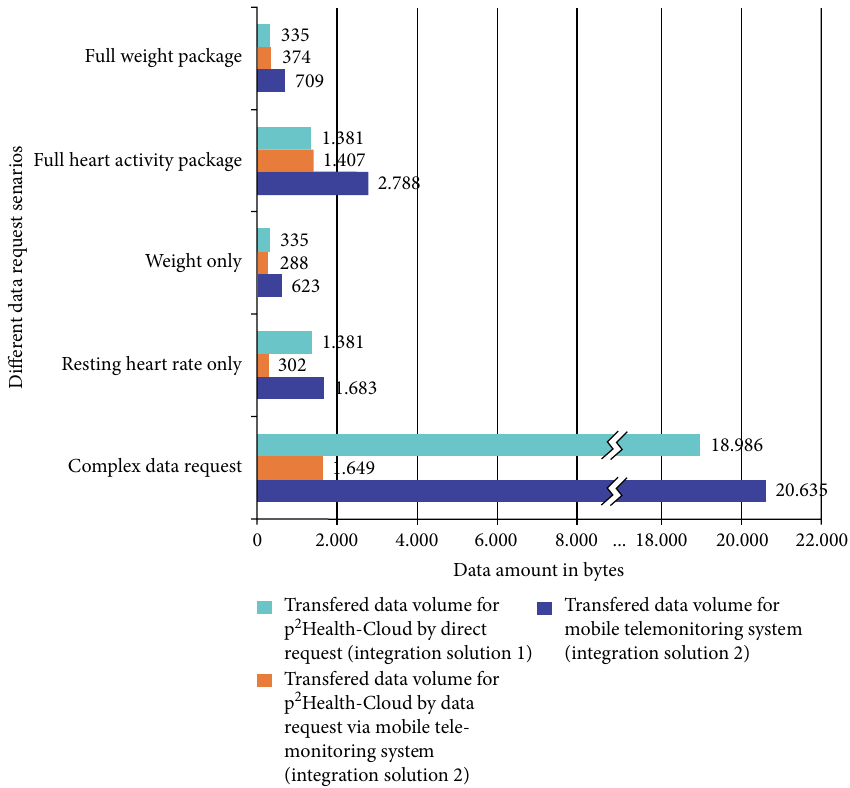
Figure 8: Comparison of the handled data volume depending on selected categories of data sets (package, single value, complex data set) and used integration